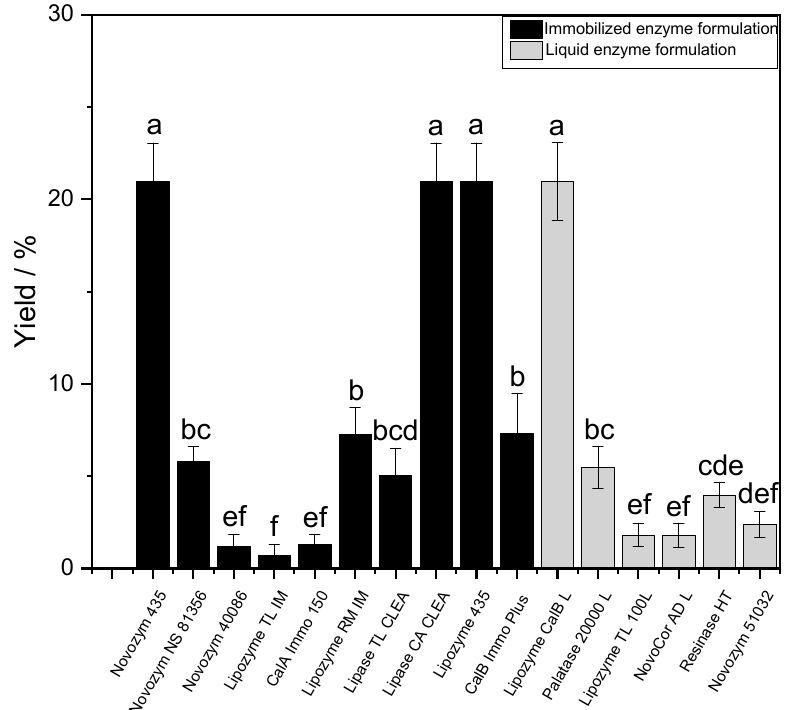
Figure 2. Comparison of SL conversion yields calculated from 0.5 M vinyl laurate. A triplicate was done for each screened commercially available formulation after 48 h at 50 °C. a–f show statistically significant differences ( p < 0.05).